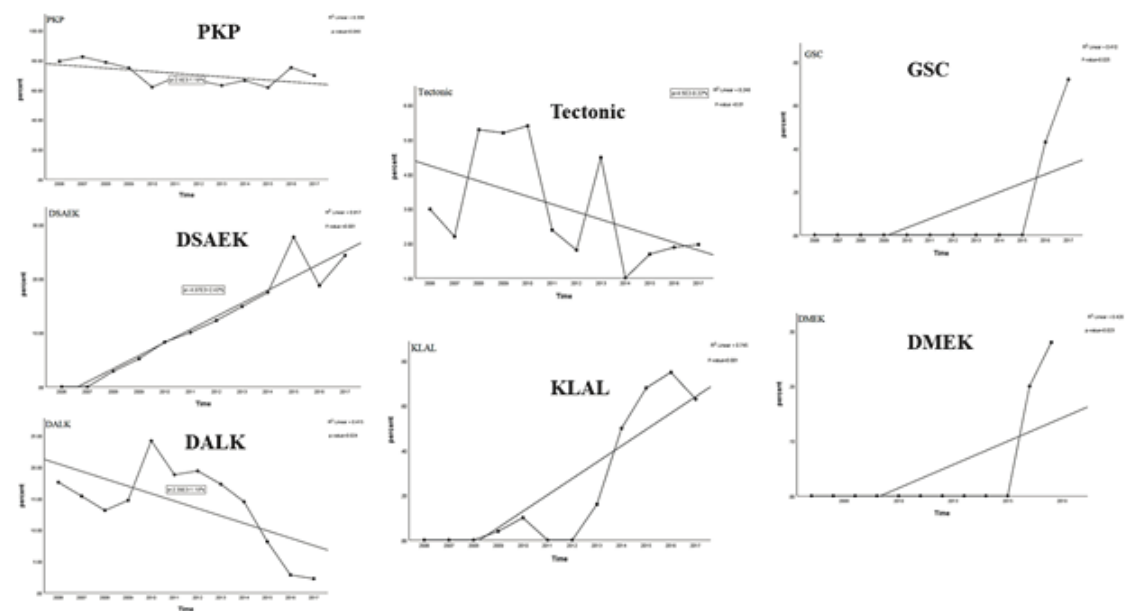
Figure 4. Trends of keratoplasty techniques from 2006 to 2017 in Iran. A significant decreasing trend for the rates of penetrating keratoplasty ( P = 0.048), anterior lamellar keratoplasty ( P = 0.024), and tectonic surgery ( P = 0.01) is observed. A significant increasing trend of change for the rates of Descemet stripping automated endothelial keratoplasty ( P < 0.001), keratolimbal allografts ( P < 0.001), glaucoma shunt coverage ( P = 0.025), and Descemet membrane endothelial keratoplasty ( P = 0.023) since their introduction is observed. The regression R 2 measures the goodness of fit of the regression line. DMEK, Descemet membrane endothelial keratoplasty; DSAEK, Descemet stripping automated endothelial keratoplasty; KLAL, keratolimbal allografts; GSC, glaucoma shunt coverage; PKP, penetrating